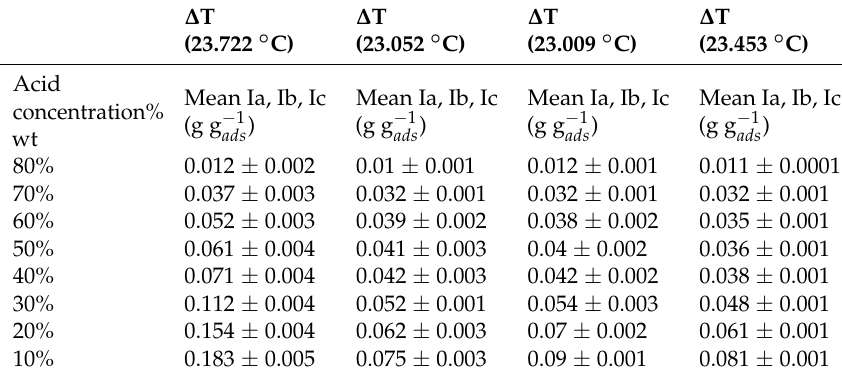
Table 1. Adsorption of samples at different concentrations ( H 2 SO 4 thermodynamic equilibrium). ∆ T (23.722 ◦